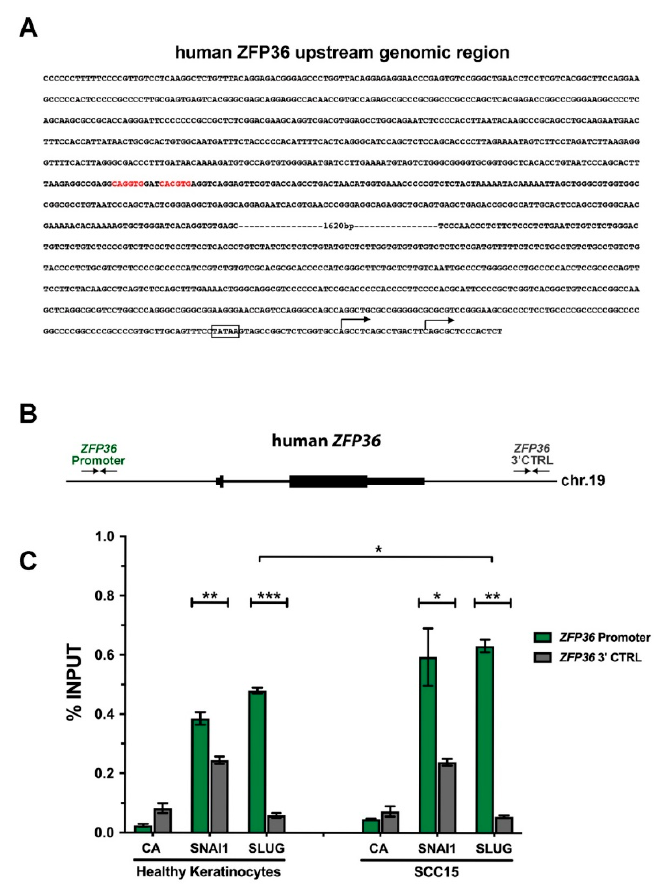
Figure 5. ( A ) Sequence of the genomic region located upstream of the human ZFP36 gene, and corresponding to the putative promoter region, is reported in bold. Two putative E-Box elements (5 (cid:48) -CANNTG-3 (cid:48) ) were indicated in red. A canonical TATA box element was highlighted by box. Two alternative transcriptional start sites (TSS) were indicated by black arrows. ( B ) Schematic representation of the human genomic region encompassing the ZFP36 locus. Inward facing arrows display the primer set amplifying the ZFP36 promoter region ( ZFP36 Promoter) and a negative control region located downstream from the ZFP36 gene ( ZFP36 3 (cid:48) CTRL). ( C ) Chromatin immunoprecipitations were performed with anti-SNAI1 and anti-SLUG antibodies. CA = control antibody. Green bars represent the binding on the ZFP36 promoter region whereas dark grey columns indicate the enrichment on its relative control region. Data are expressed as mean percentage of total input chromatin ± SEM of at least three independent experiments. * p -value ≤ 0.05; ** p -value ≤ 0.01; *** p -value ≤ 0.001 evaluated with t